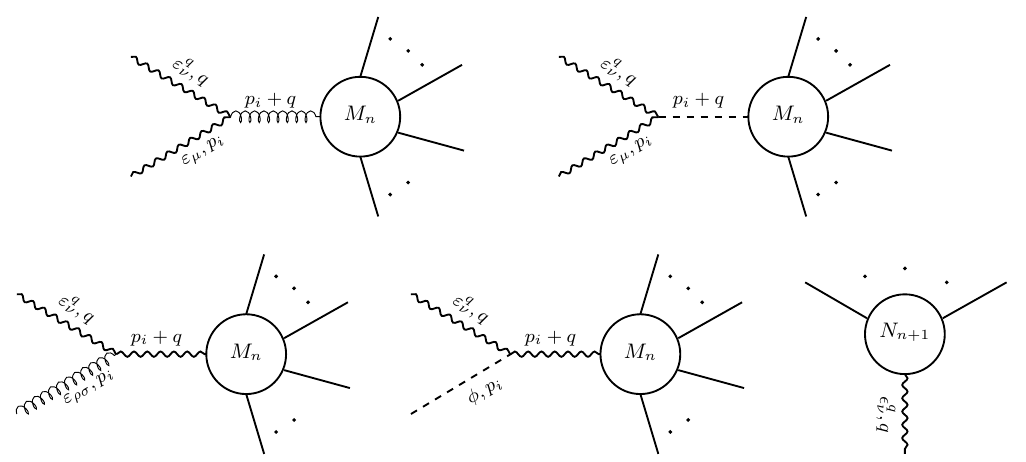
Figure 1 . The diagrams contributing to the calculation in section 4.1. The 2 topmost diagrams correspond to the case when the internal state is a graviton or scalar whereas the (cid:12)rst 2 bottom diagrams correspond to the case when the graviton or scalar are external states attached to the soft vector (cid:12)eld. The last diagram denotes the amplitude without any pole in soft momenta. 1. The diagram with a soft vector state attached on a hard vector state and with a graviton as intermediate state is given